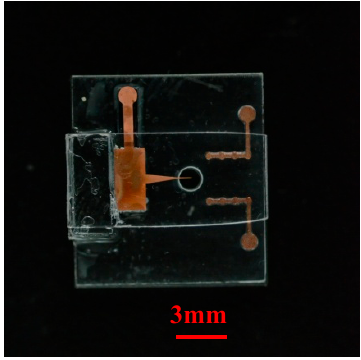
Figure 2. The micro ion source chip.